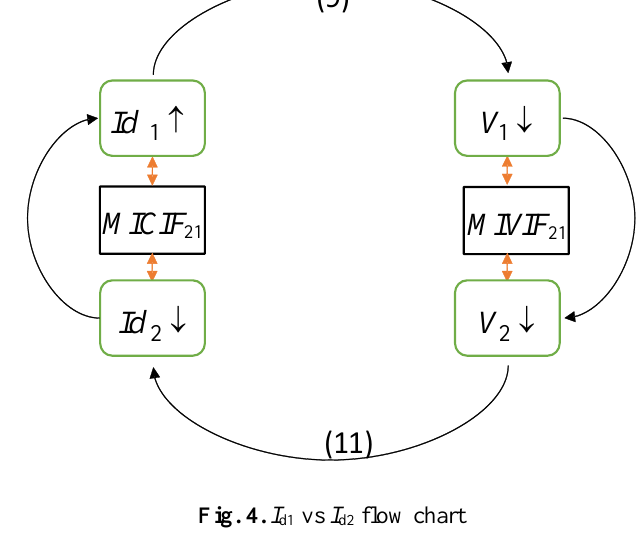
Fig. 4. I d1 vs I d2 flow chart